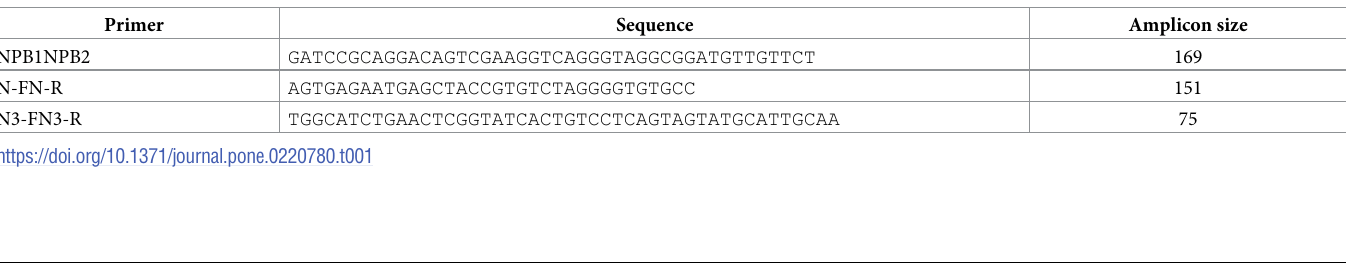
Table 1. Primer pairs targeting the N gene of measles